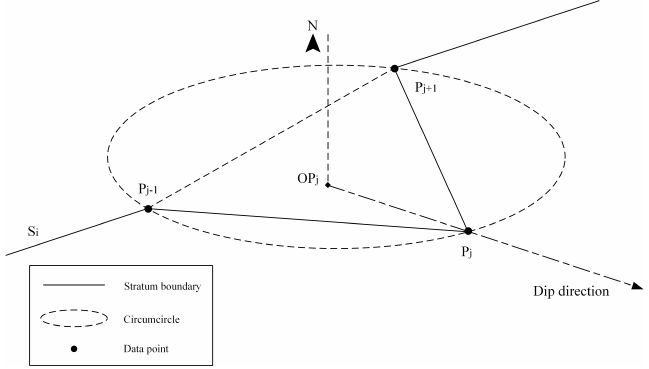
Figure 5. Schematic diagram explaining the curvature method for calculating the dip direction. The dip direction of the boundary point P j points to inside and is judged to be abnormal. At this time, based on the curvature method, the dip direction of P j can be changed to point from the center OP j of the circumcircle to P j